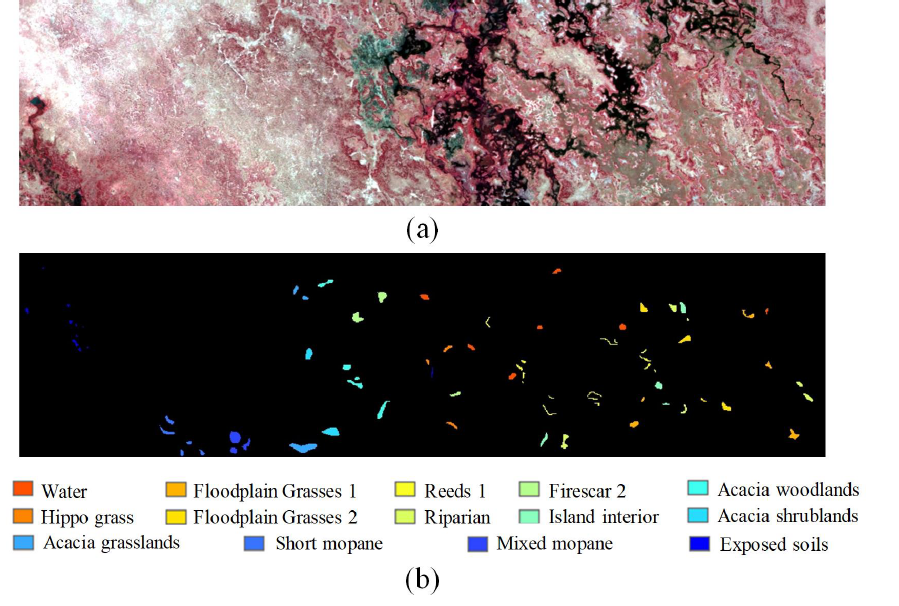
Figure 5. The Botswana scene: ( a ) false-color composite image; ( b ) ground